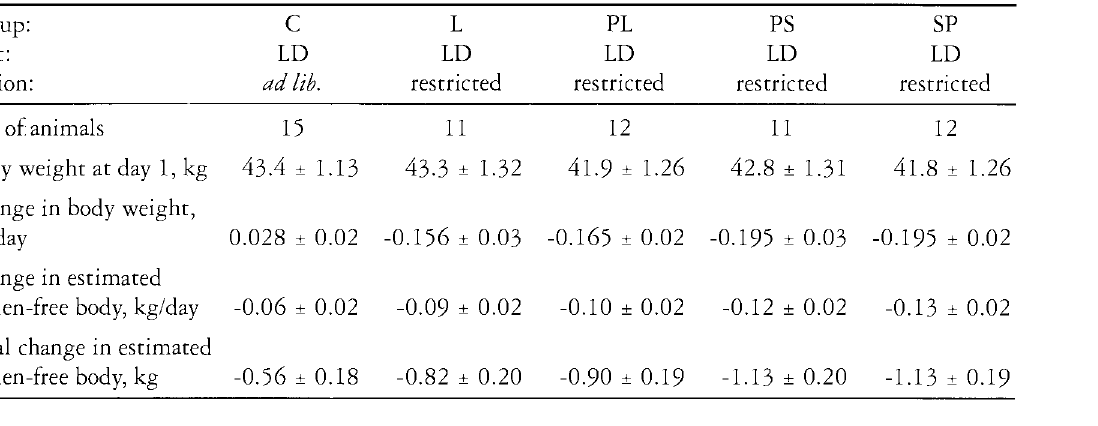
Table 4. Number of reindeer, body weight at the start of the feeding period (day 10) and calculated changes in body weighr during the feeding period, days 10 -42 (least-square mean + standard error). LD = lichen-based diet, Pe = pellets, Li = lichens, Si =